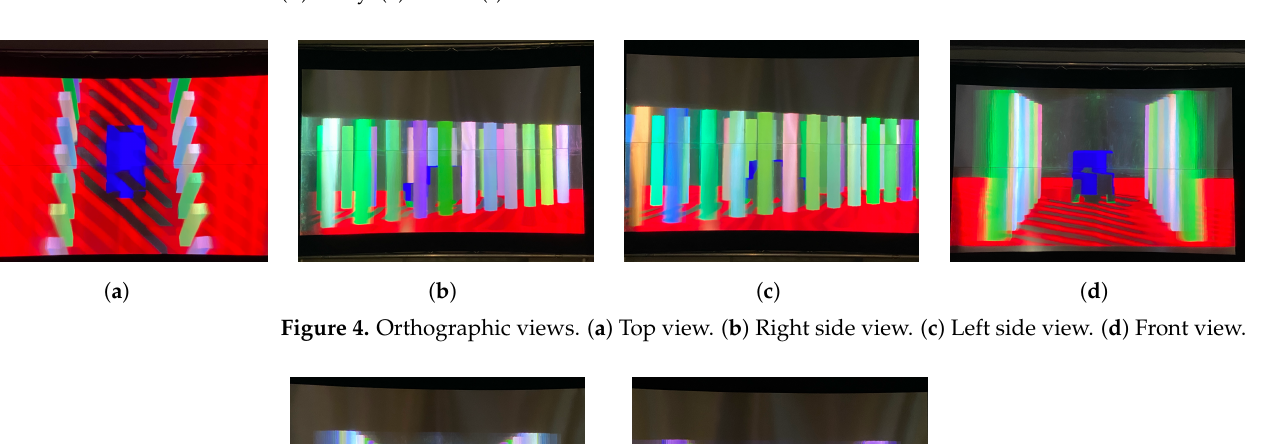
Figure 3. Cinematography camera animations on the light field display. ( a ) Pan. ( b ) Tilt. ( c ) Zoom. ( d ) Dolly. ( e ) Truck. ( f ) Pedestal.